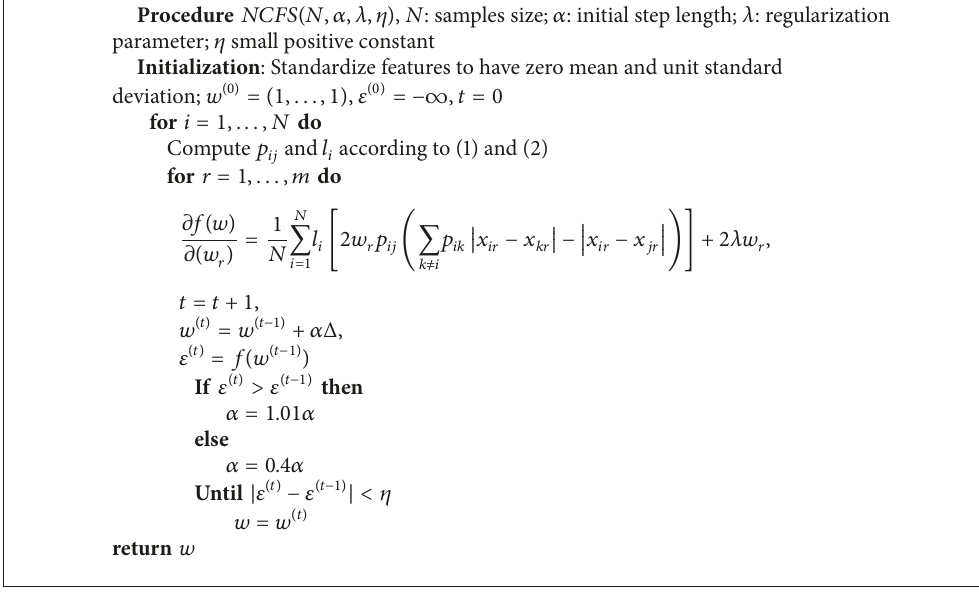
Algorithm 2: Neighborhood component feature